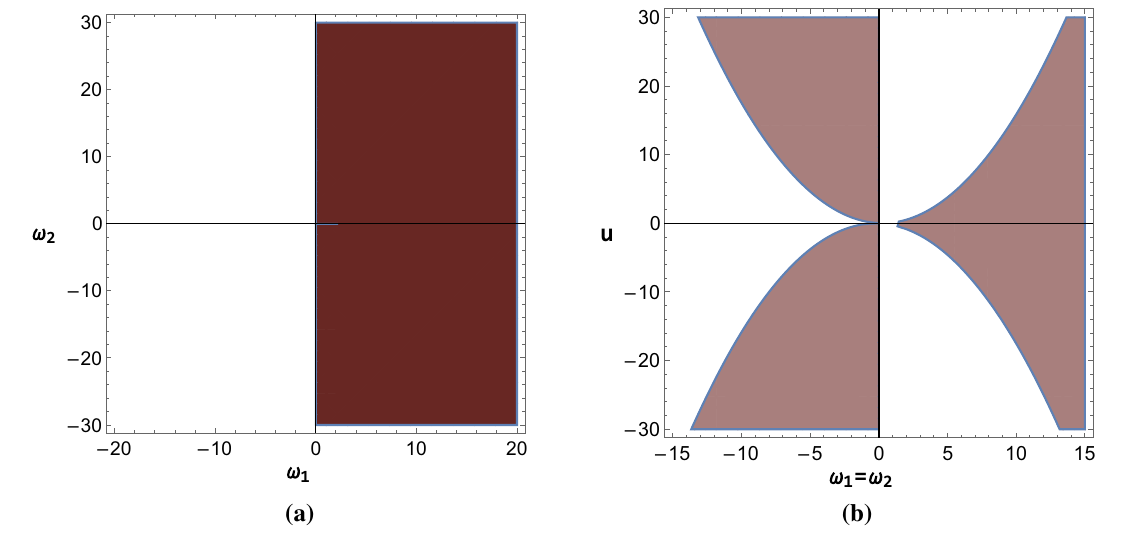
Fig. 2 a The case where the critical line A has a saddle cosmological behavior, considering w m = 0, u = 0, α = 1 (left panel), b the situation where A corresponds to a saddle critical line, considering w m = 0, ω 1 = ω 2 , α = 1 (right panel)